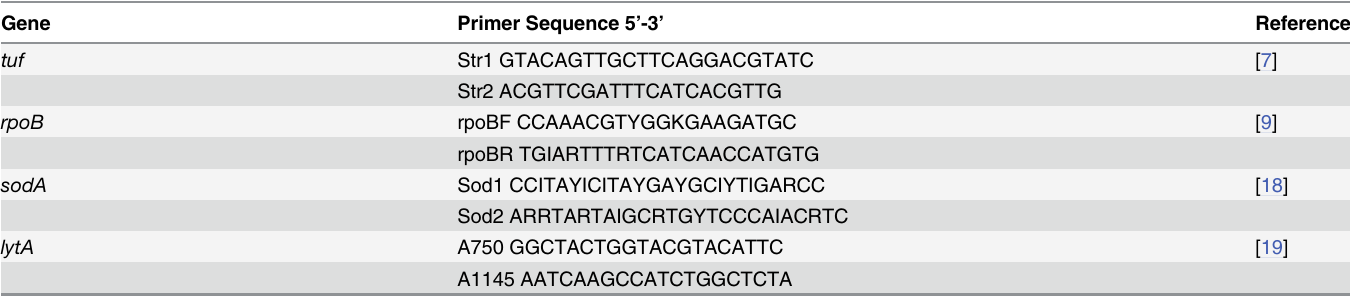
Table 1. Sequences of oligonucleotides used in this study.